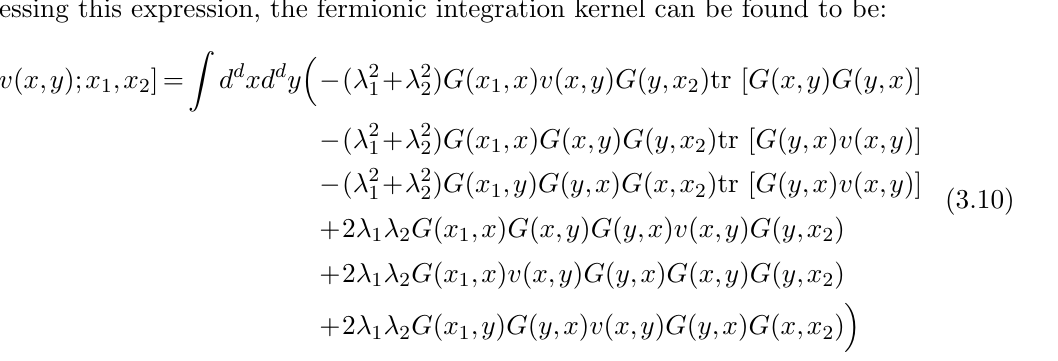
Figure 3. Feynman diagrams corresponding to melonic Wick contractions proportional to (cid:21) 2 The above diagram shows contraction of spinor indices, and the lower diagram shows contraction of colour